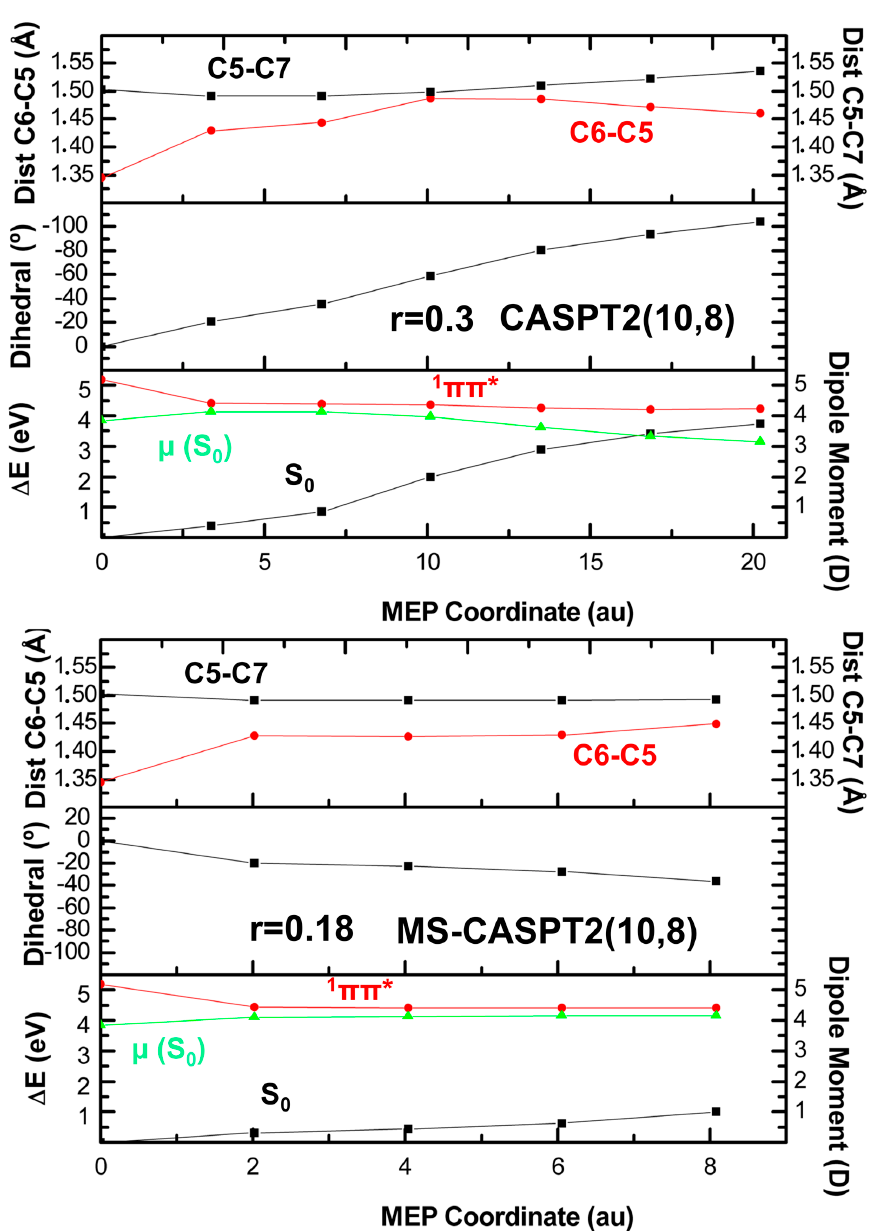
Figure 3. CASPT2 energies and CASSCF dipole moments ( μ ) of the ground and lowest-lying 1 ππ * excited state plus main geometrical distortions along the MEPs of the 1 ππ * from the Franck-Condon region computed with CASPT2//CASPT2 and MS-CASPT2//MS-CASPT2 with the 6-31G* basis set. As in CASPT2//CASSCF, additional computations have been carried out to characterize the 1 (n O π *) minimum, employing CASSCF(14,10). The minimum has been computed at the CASPT2 and MS-CASPT2 levels employing the 6-31G* basis set. Shorter C4=O distances (~1.365 Å) are obtained as compared to those previously reported with the CASSCF method, and a nearly planar structure displaying a C6C5C4O dihedral of − 178° (see SI), contrary to CASSCF fi ndings. It is worth noting that both CASPT2 and MS-CASPT2 converge to the same structure, the choice of zeroth-order Hamiltonian exerting a lesser influence in this case as opposed to what has been previously reported for 1 ( ππ *), which can be related to the different nature of the states: zwitterionic ( ππ *) and covalent (n π *).